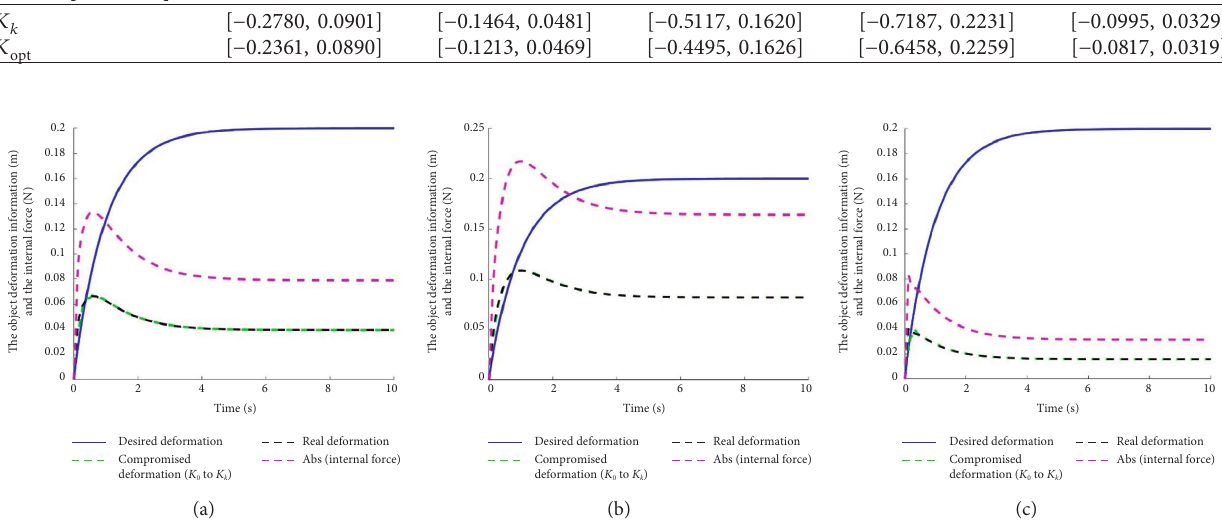
Figure 12: The deformation information and the internal force in the condition with different weights. (a) W